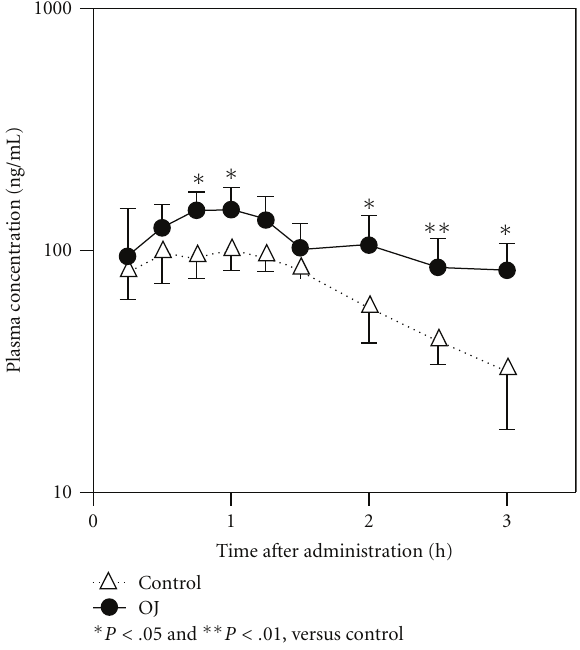
Figure 1: E ff ect of orange juice (OJ) on the plasma concentration of pravastatin (PRV) in Sprague-Dawley rats. OJ was administered orally 8 times (1st day) and 5 times (2nd day) at hourly intervals. The starting dose of OJ was 5mL/kg, and each consecutive dose was 2.5mL/kg. Tap water instead of OJ was given to the control group. A single dose of PRV at 100mg/kg p.o. was administered 1h after the last ingestion of OJ or tap water. PRV levels were measured using the HPLC method described in Section